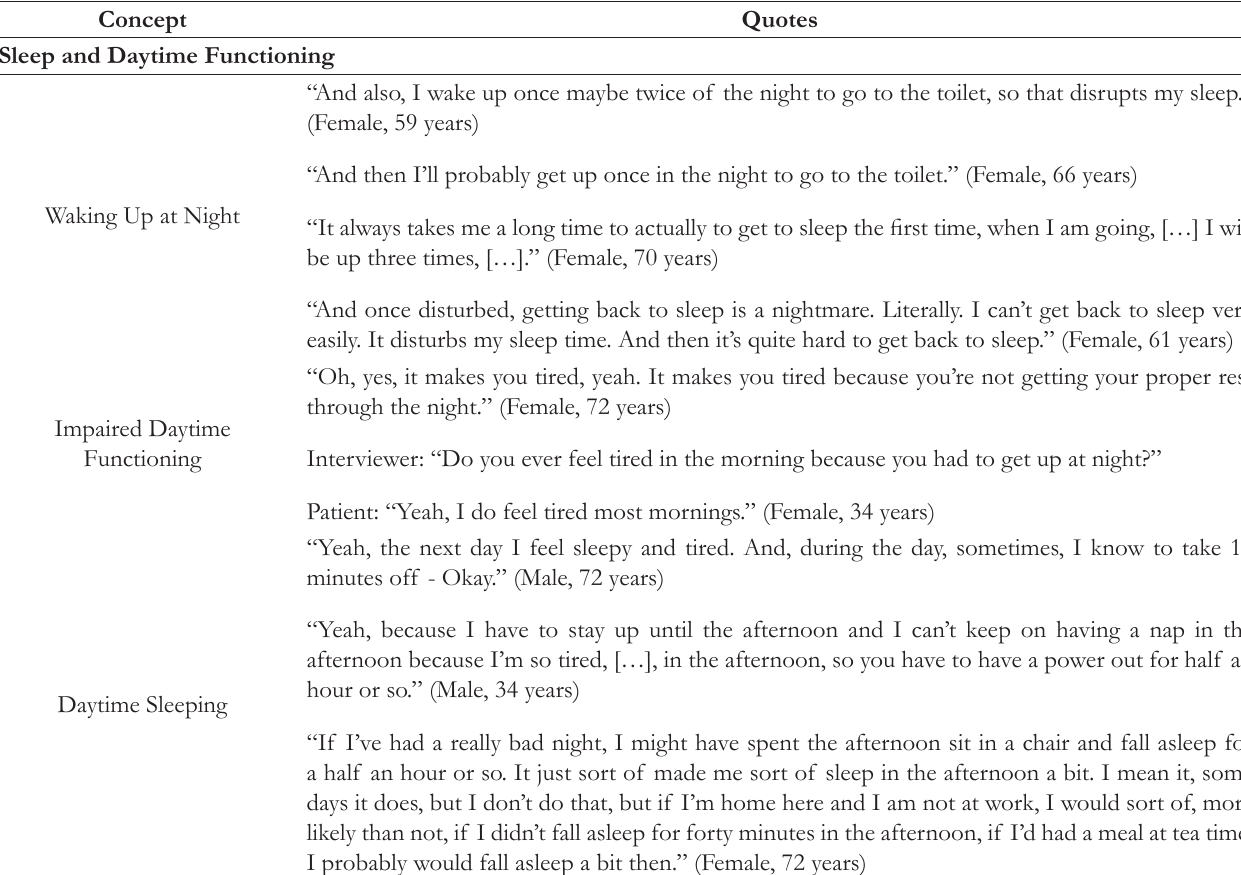
Table 2. Concepts and Illustrative Quotes Pertaining to Those Concepts -